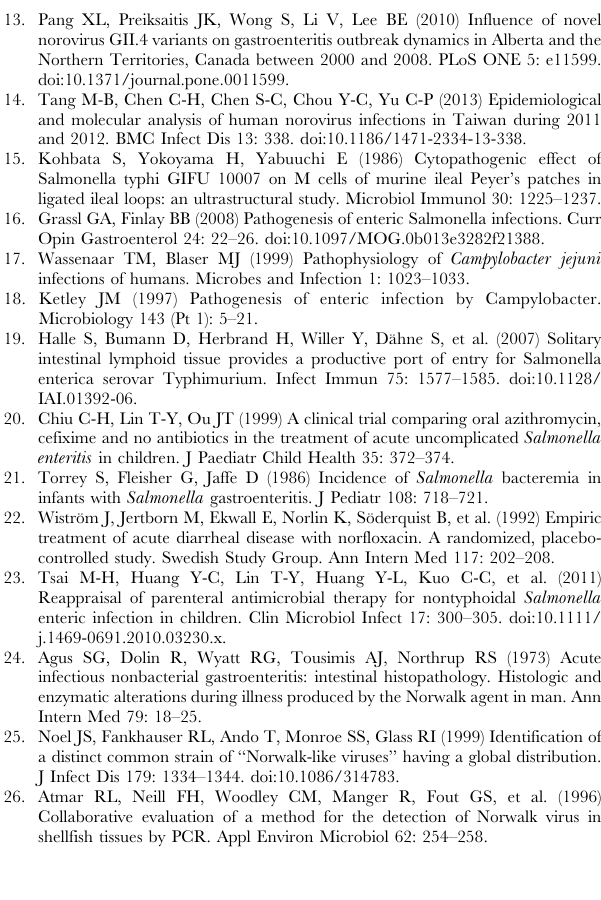
Table S1 Sequences and BLAST results of